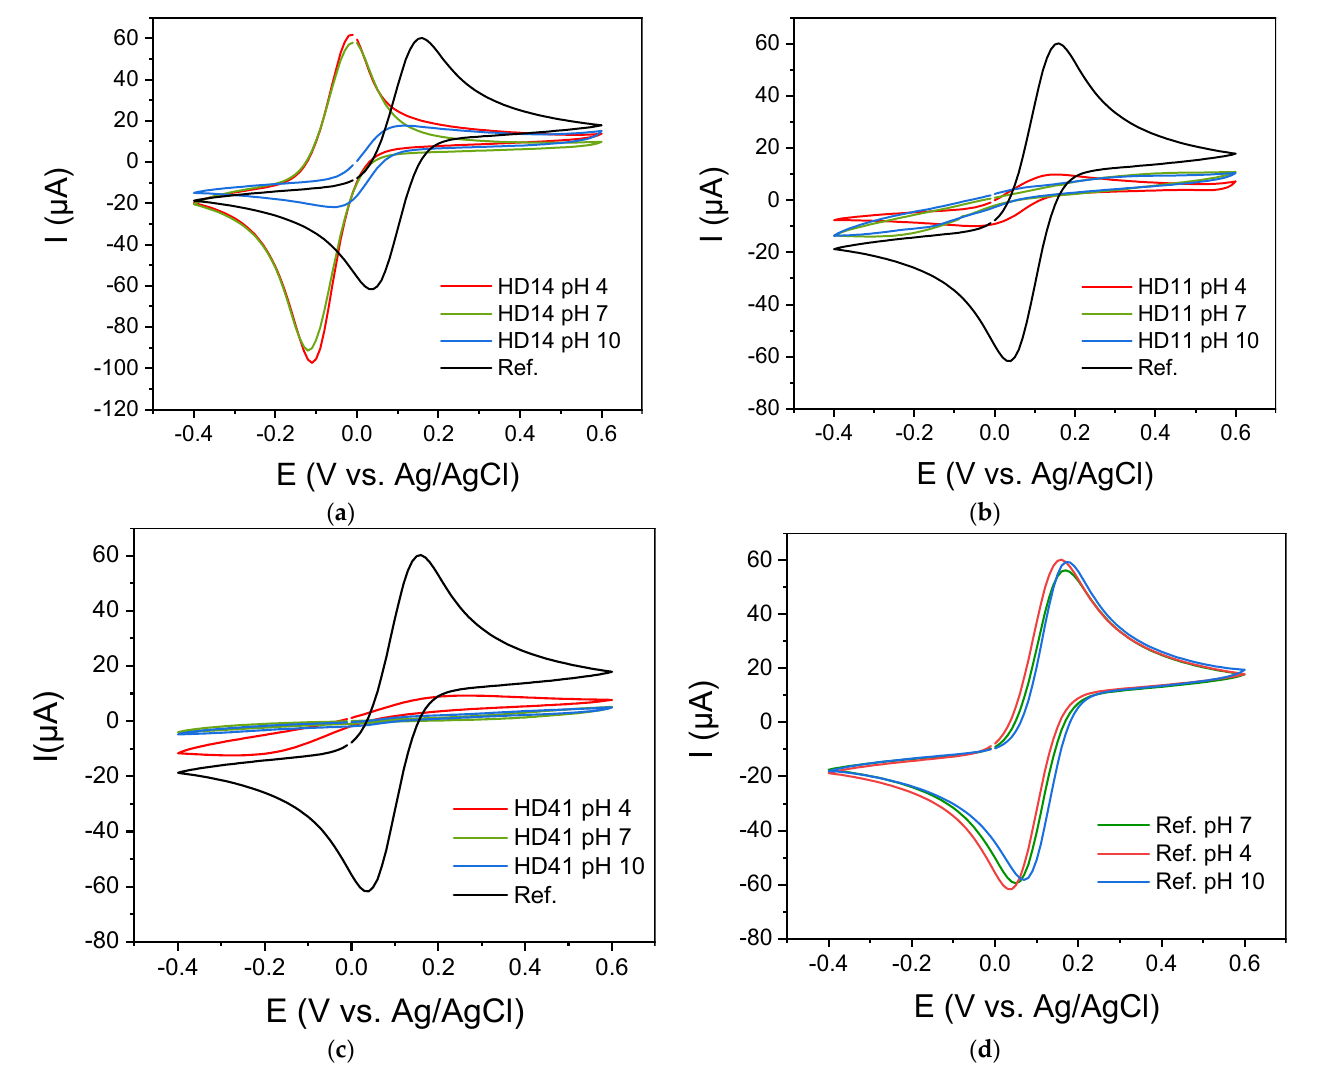
Figure 9. Cyclic voltammograms ( a – c ) of the plasma-polymerized d-HD films acquired in buffer solutions of different pHs, ( d ): [Fe(CN) 6 ] 3 − /4 − at the bare gold electrode in solutions of different pHs. CV recordings of n-HD films in different pHs are shown in Figure S11.